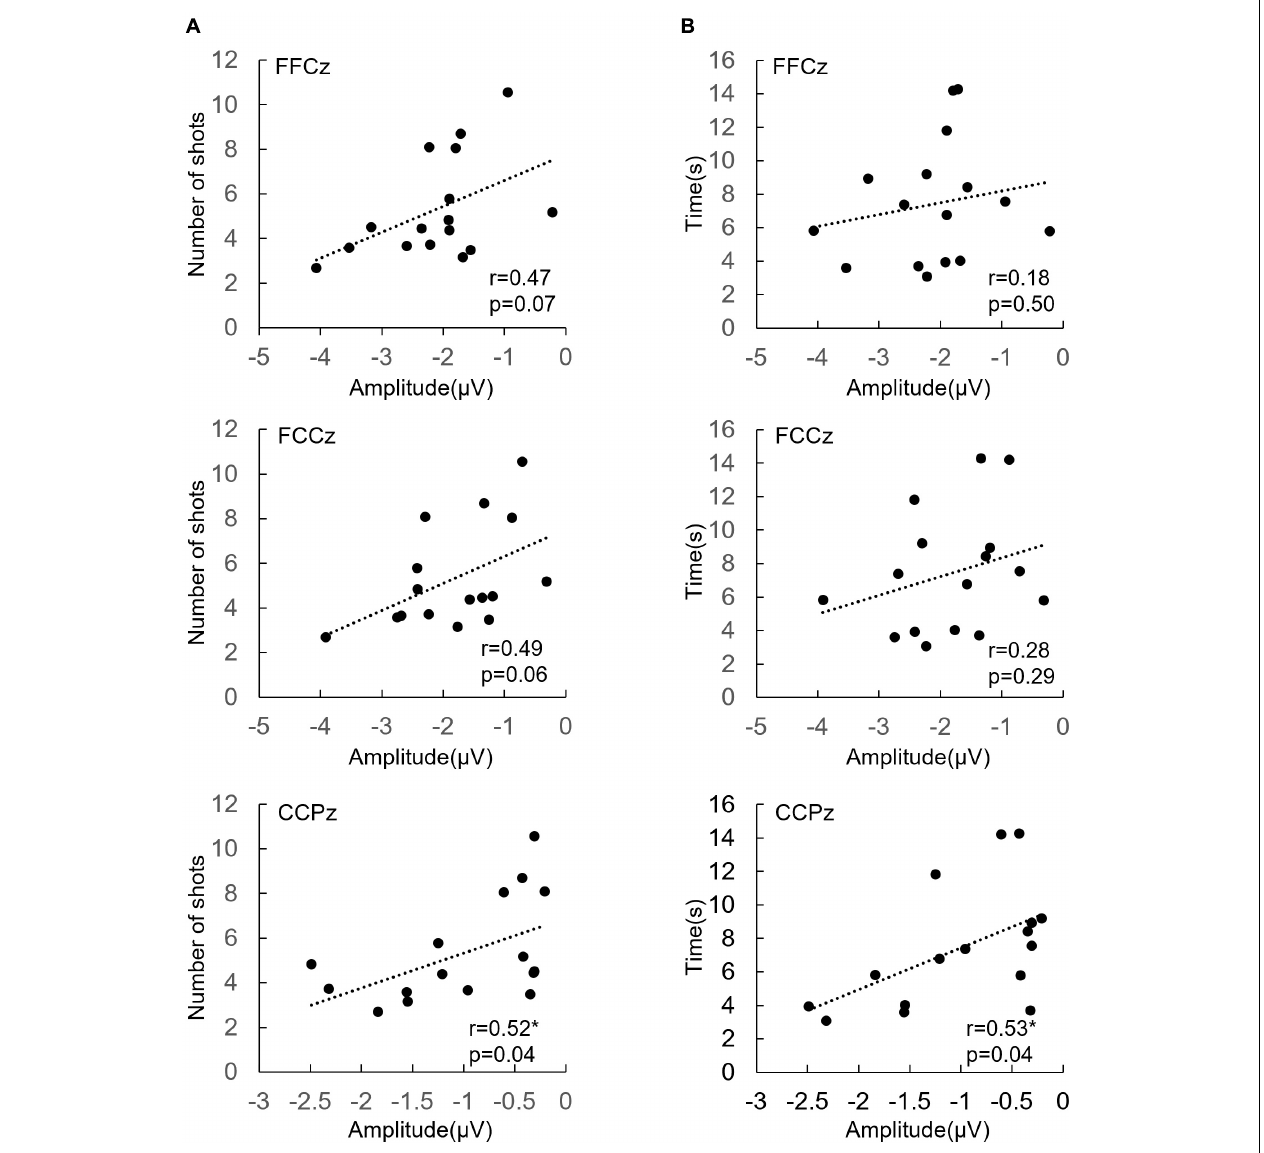
FIGURE 3 | (A) The correlation between ERN at FFCz, FCCz, and CCPz from each participant ( n = 16) and shots per kill. (B) The correlation between ERN at FFCz, FCCz, and CCPz from each participant ( n = 16) and seconds per kill. * p <